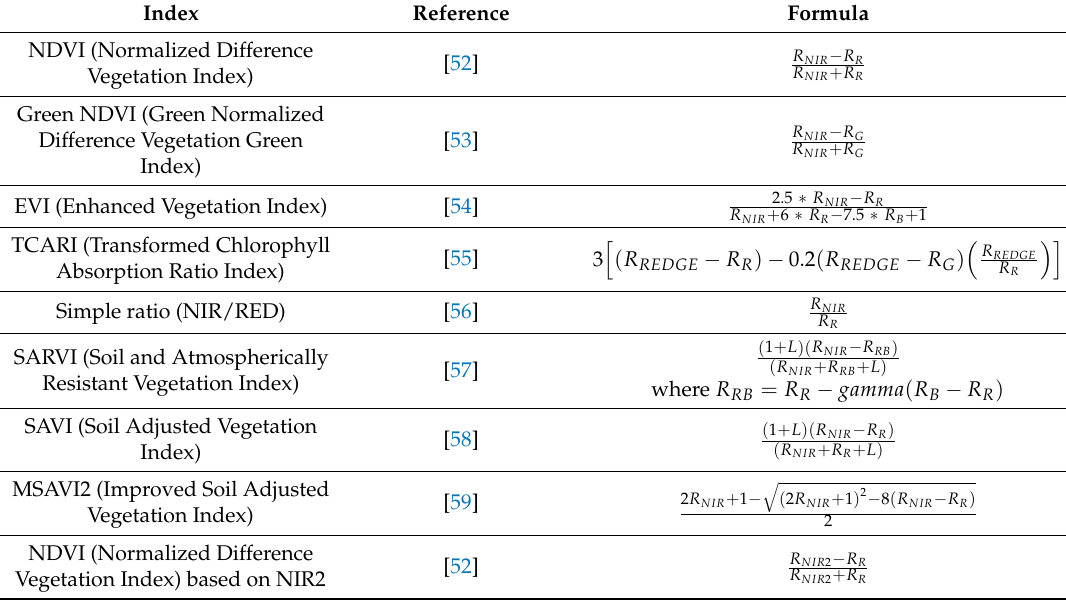
Table 5. Empirical indices proposed frequently in remote sensing of